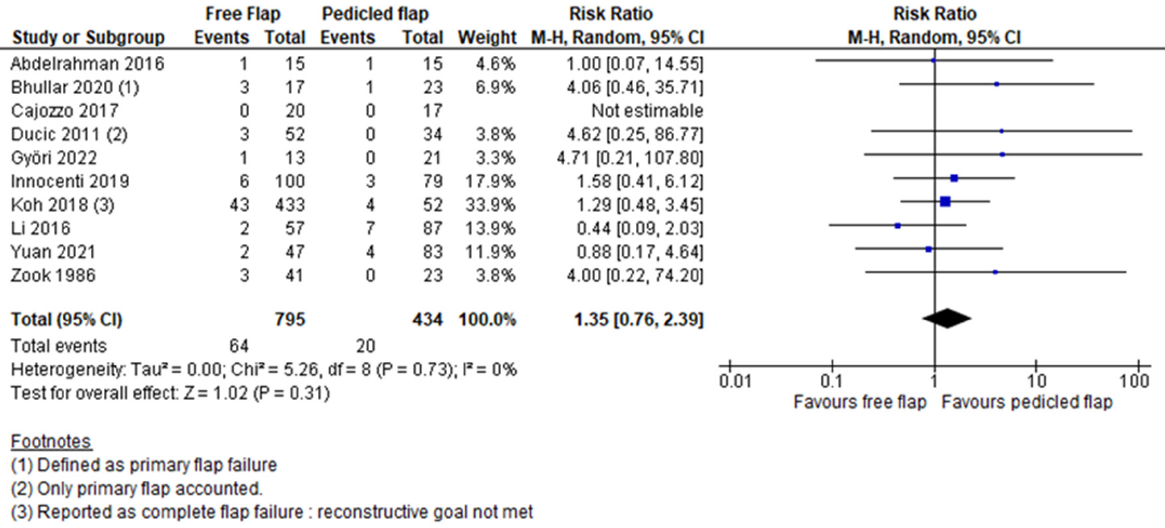
Figure 2. Total flap necrosis meta-analysis [12–21].